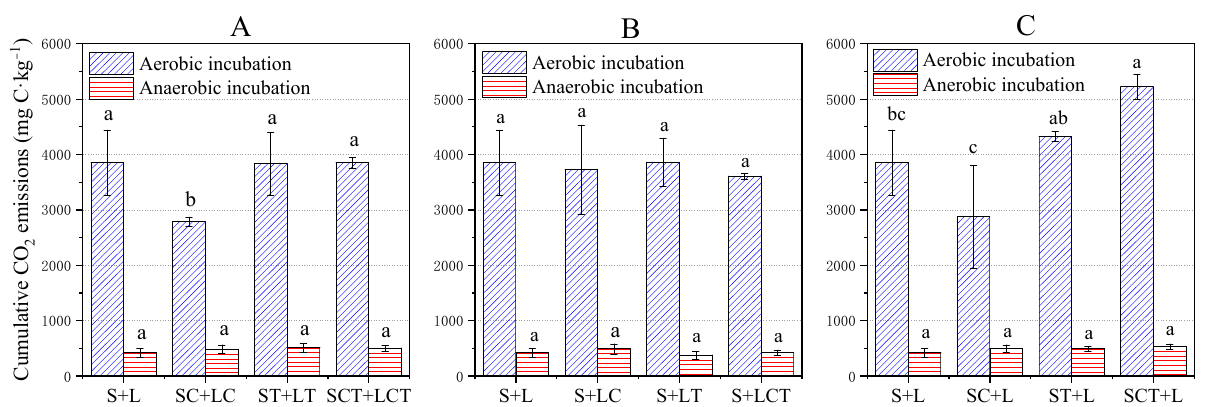
Figure 3. The cumulative CO 2 emission during aerobic and anaerobic stage. Please refer to Table 1 for the treatment abbreviations. The letters A, B and C represent Experiment Ⅰ , Experiment Ⅱ and Experiment Ⅲ , respectively. Different lower-case letters indicate significant differences among treatments ( p < 0.05). Table 3. Person correlation between soil respiration during the aerobic period and soil